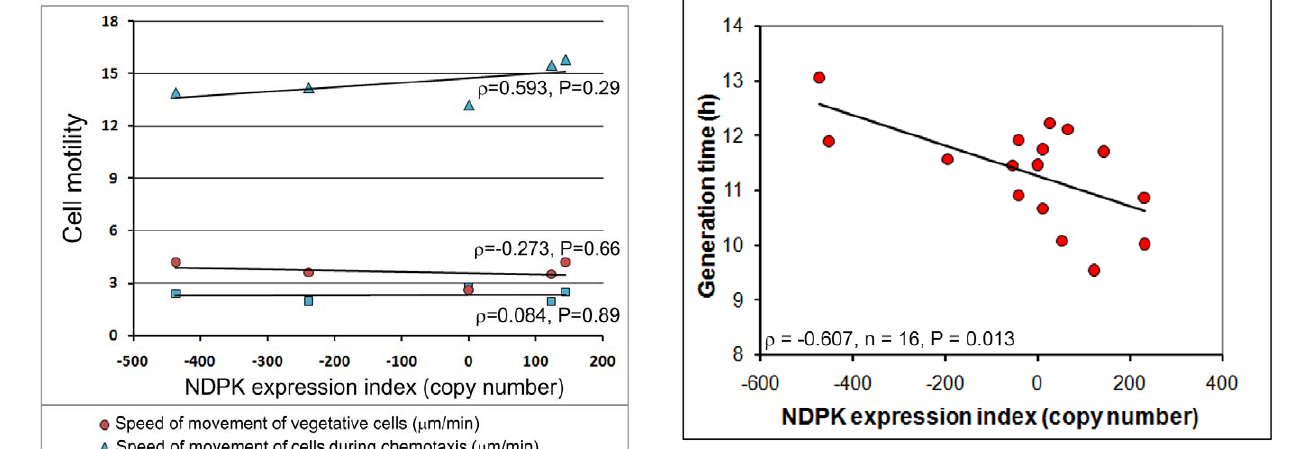
Figure 8. NDPK stimulates growth in liquid medium. The generation time for wild type and NDPK transformants was measured in three independent experiments and the mean for each transformant was plotted against the NDPK expression index (defined as in Fig. 5). The generation times decreased as the level of NDPK expression increased. The correlation was significant at P , 0.05 (Pearson product- moment correlation coefficient r ).